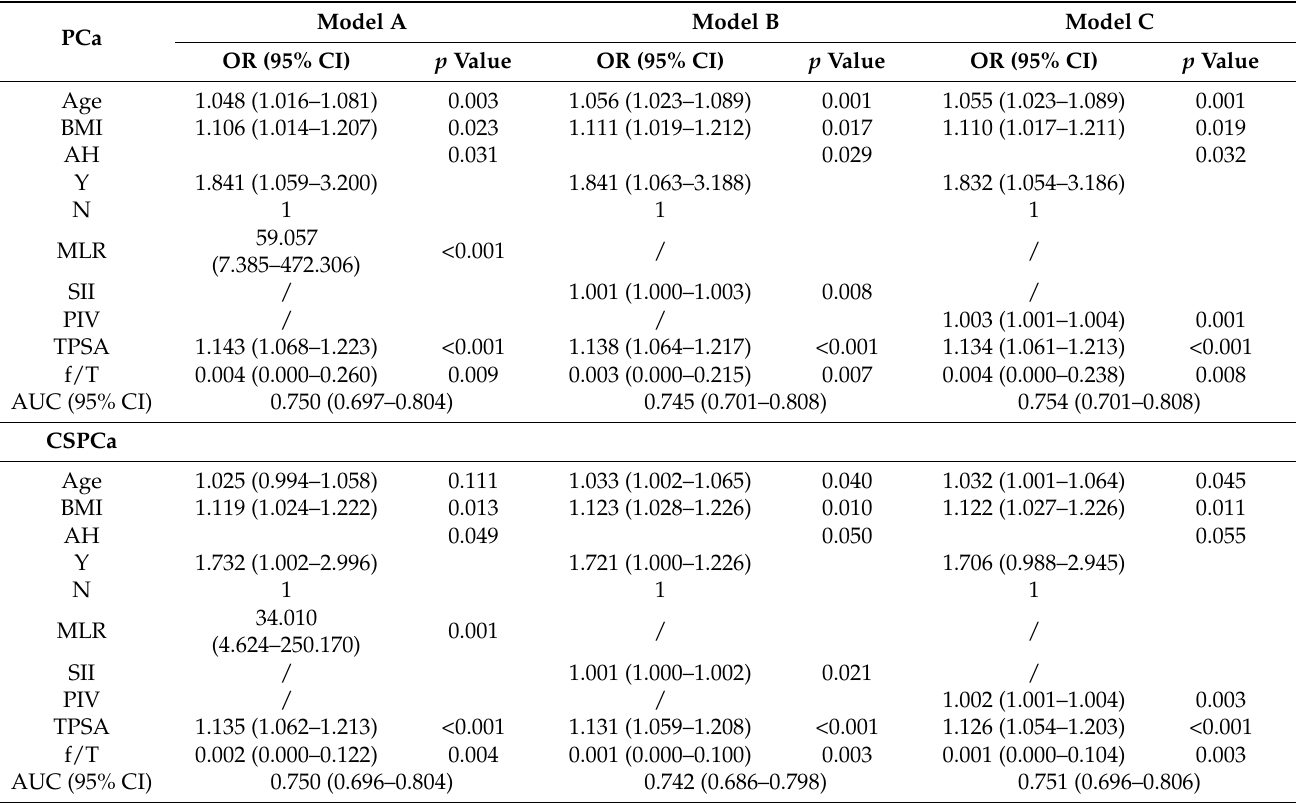
Table 3. Multivariable logistic regression analysis of different models of inflammatory markers.